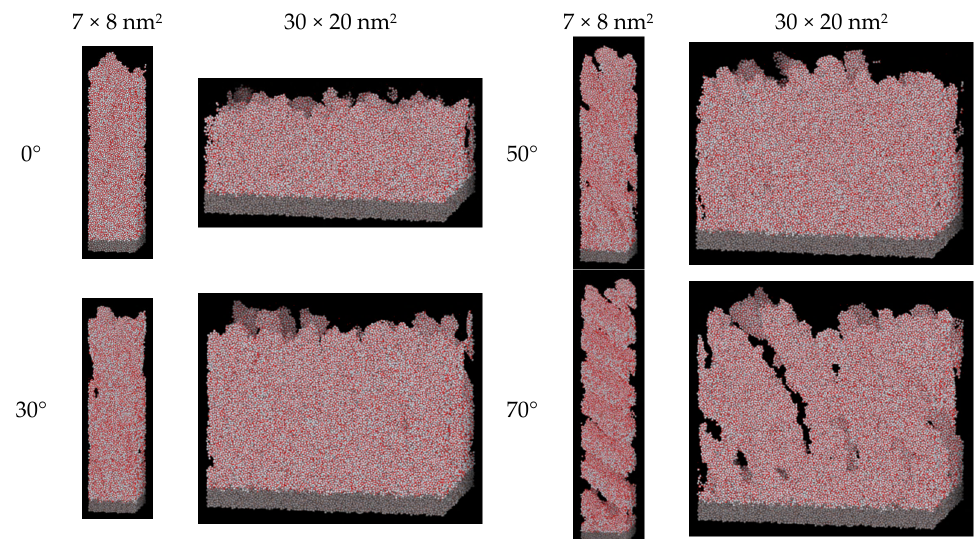
Figure 2. Simulated structures of TiO 2 for different deposition angles of 0°, 30°, 50° and 70° and substrate sizes of 7 × 8 nm 2 and 30 × 20 nm 2 . The substrate is shaded in grey. Graphics generated with NGL [16,17].